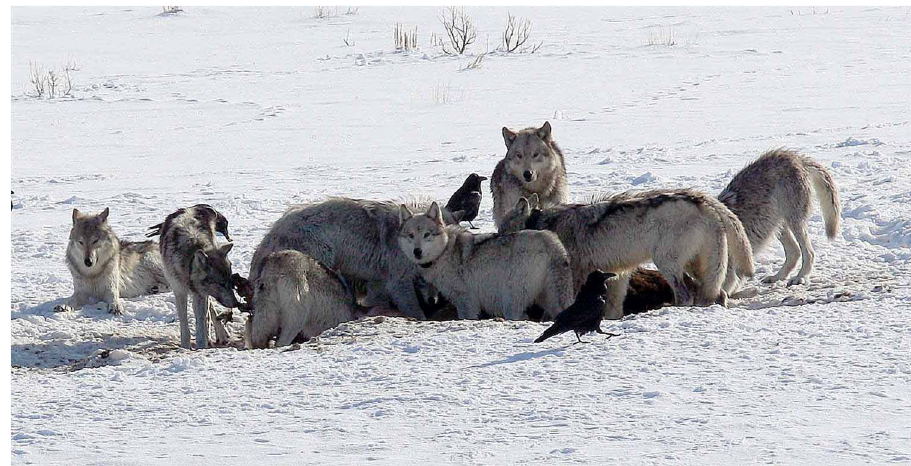
Fig. 1. Wolves in Yellowstone NP. Photo credit: Daniel Stahler/National Park Service (NPS) photo from http://www.yellowstonewolf.org/, a site at which information and pictures of Yellowstone wolves can be found.